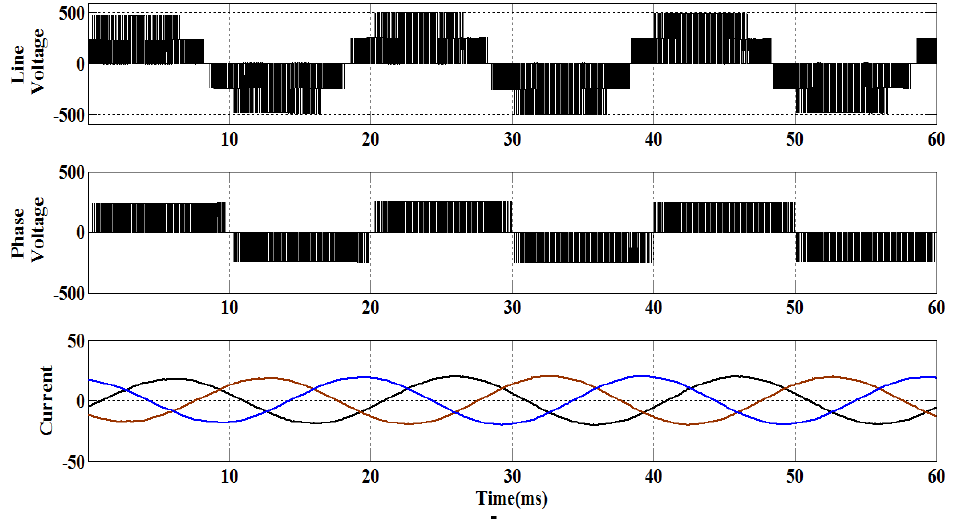
Figure 14. Output waveforms of the TC-ZSI with a single impedance network using the APOD PWM technique (configuration Figure 8).